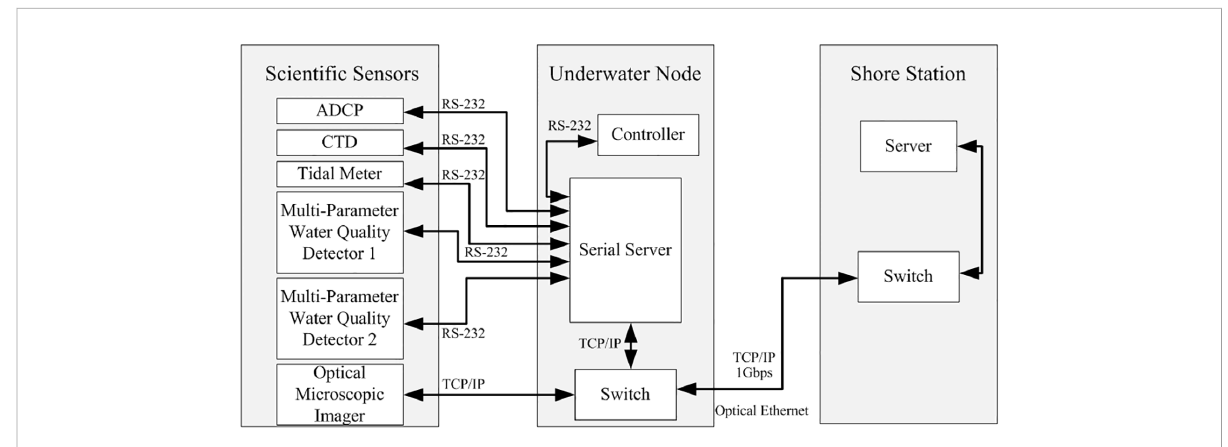
FIGURE 6 Block diagram of communication